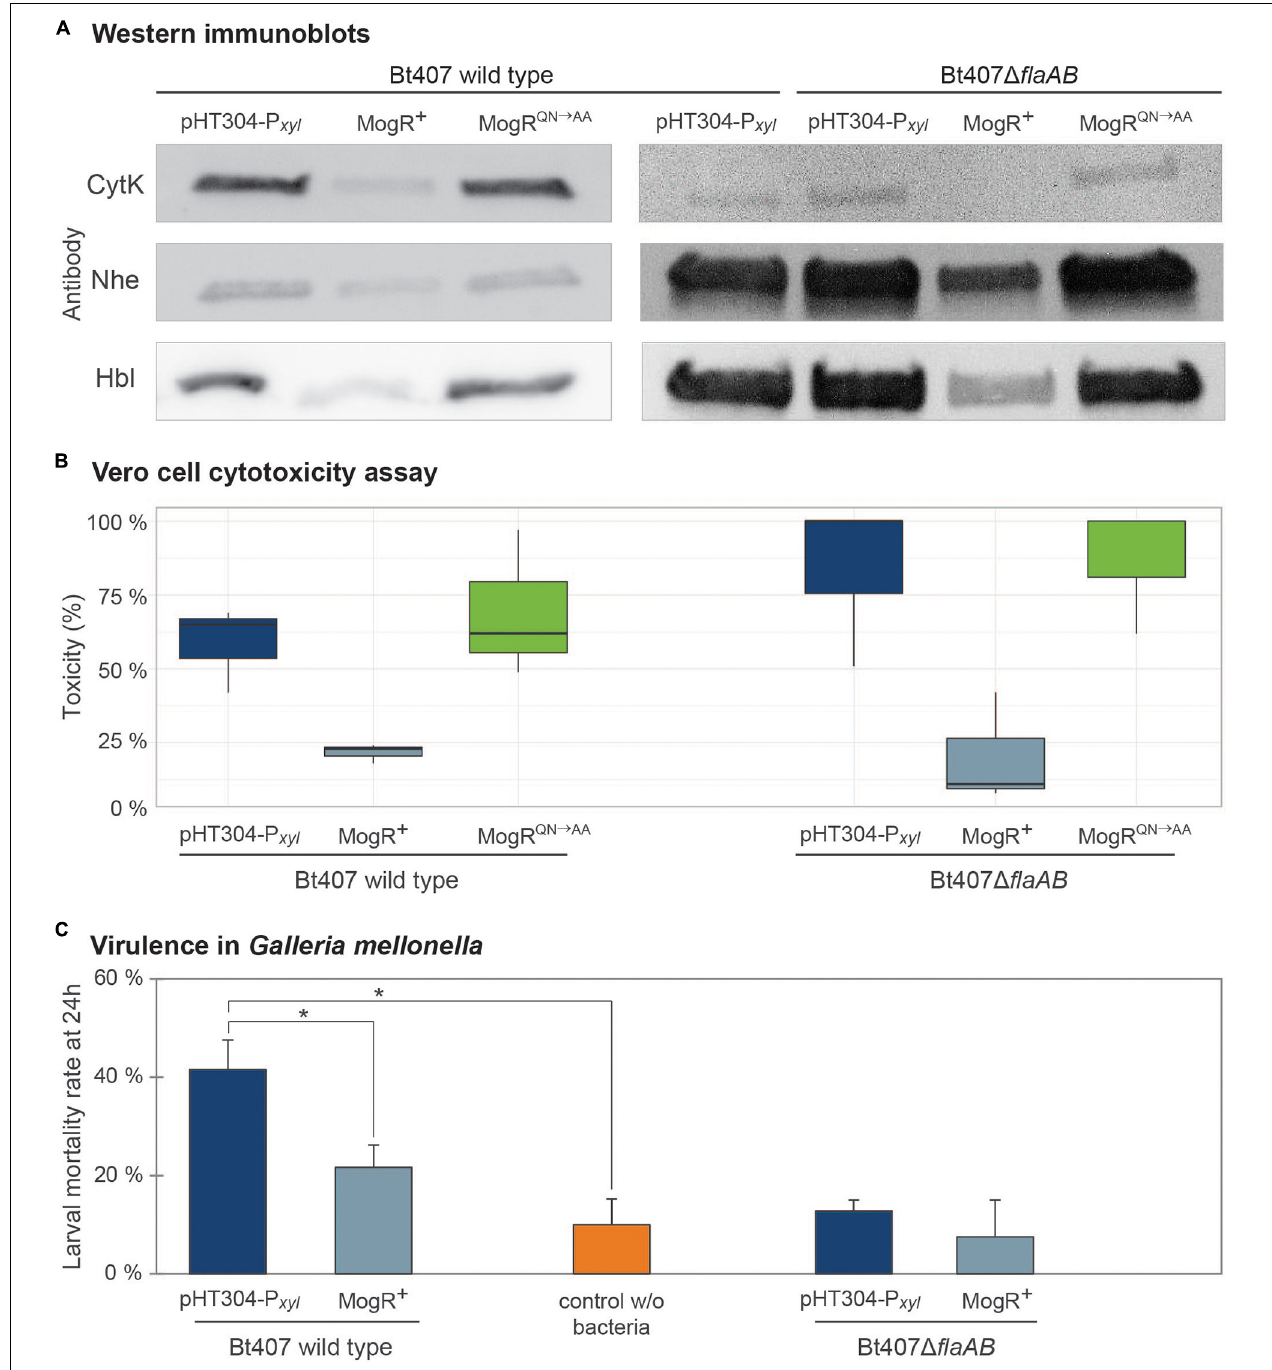
FIGURE 6 | Analysis of the effect of overexpression of MogR on virulence and toxicity phenotypes. (A) Immunoblots against CytK, Nhe and Hbl enterotoxins using culture supernatants from B. thuringiensis 407 carrying the empty vector (pHT304-P xyl ), a MogR overexpression strain (MogR + ), and a strain overexpressing a mutated form of MogR (MogR QN → AA ). Constructs were analyzed in B. thuringiensis 407 wild type and flaAB deletion ( (cid:49) flaAB ) backgrounds. Cultures were grown for 4.5 h with 1 mM xylose induction prior to harvest. The experiments were repeated at least three times and representative blots are shown. (B) Vero cell cytotoxicity assay using supernatants from cultures of the same strains as in (A) . The median and first and third quartiles (25th percentile and 75th percentile) of three independent experiments are shown, as well as whiskers indicating the data variability outside the upper and lower quartiles. (C) Virulence in Galleria mellonella insect larvae (oral force-feeding infection model), using empty vector and MogR overexpression strains, in B. thuringiensis 407 wild type and (cid:49) flaAB backgrounds, respectively. Bacteria were in all cases mixed with Cry 1C toxin and xylose. Also, a control with no bacteria but fed with Cry toxin and xylose was included. The means and standard errors of the mean (bars) of seven independent experiments are shown. Statistically significant differences (Tukey’s post hoc test, p < 0.02) are indicated with asterisks (*).